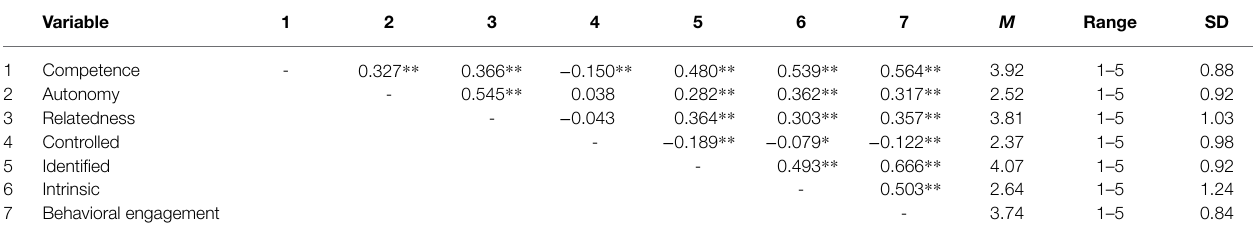
TABLE 1 | Pearson correlations and descriptive statistics for basic psychological needs satisfaction, types of regulations, and behavioral engagement.